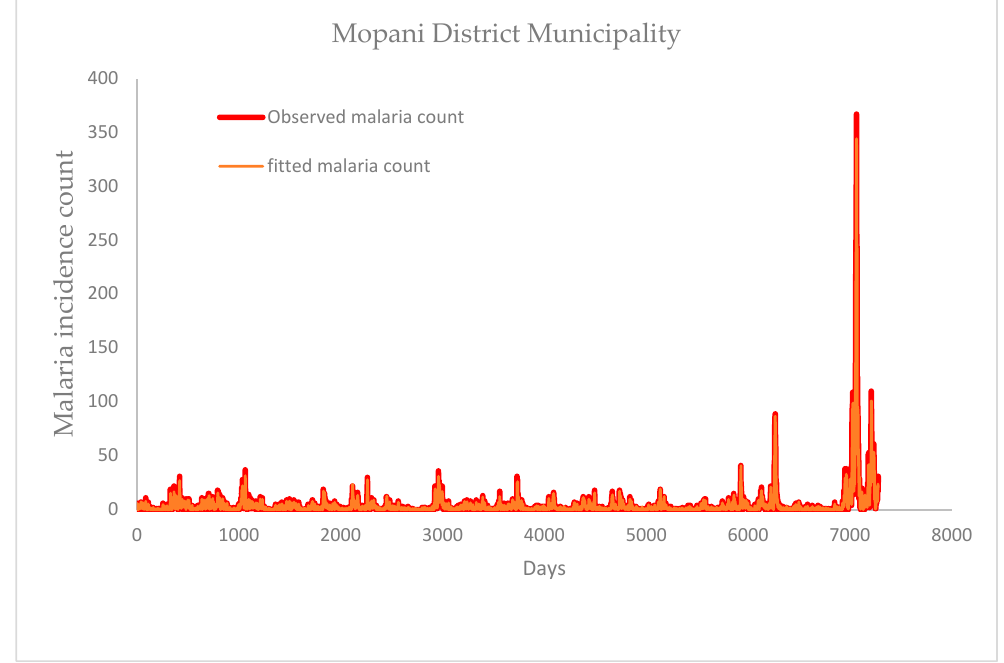
Figure 6. Plot of autocorrelation function and partial autocorrelation function of residuals of ZINB+ARIMA model for Mopani and Vhembe district municipalities.